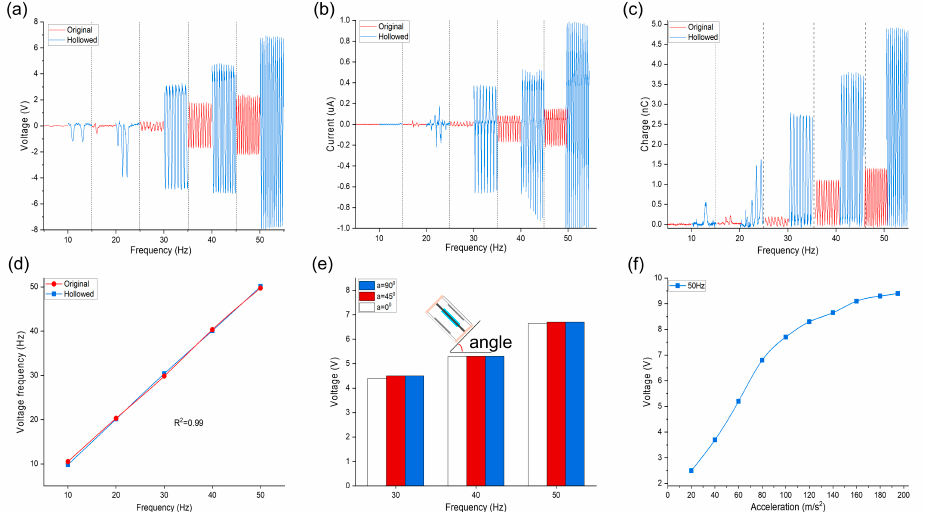
Figure 4. Output performance of ES − TENG sensors (hollow and original) at different frequencies with a fixed amplitude of 2 mm: ( a ) V OC , ( b ) short-circuit current, and ( c ) transferred charge. ( d ) FFT results of the applied vibration frequency and V OC signals; ( e ) V OC values of ES − TENG at different vibration directions; ( f ) voltage variation curves for different accelerations at 50 Hz.